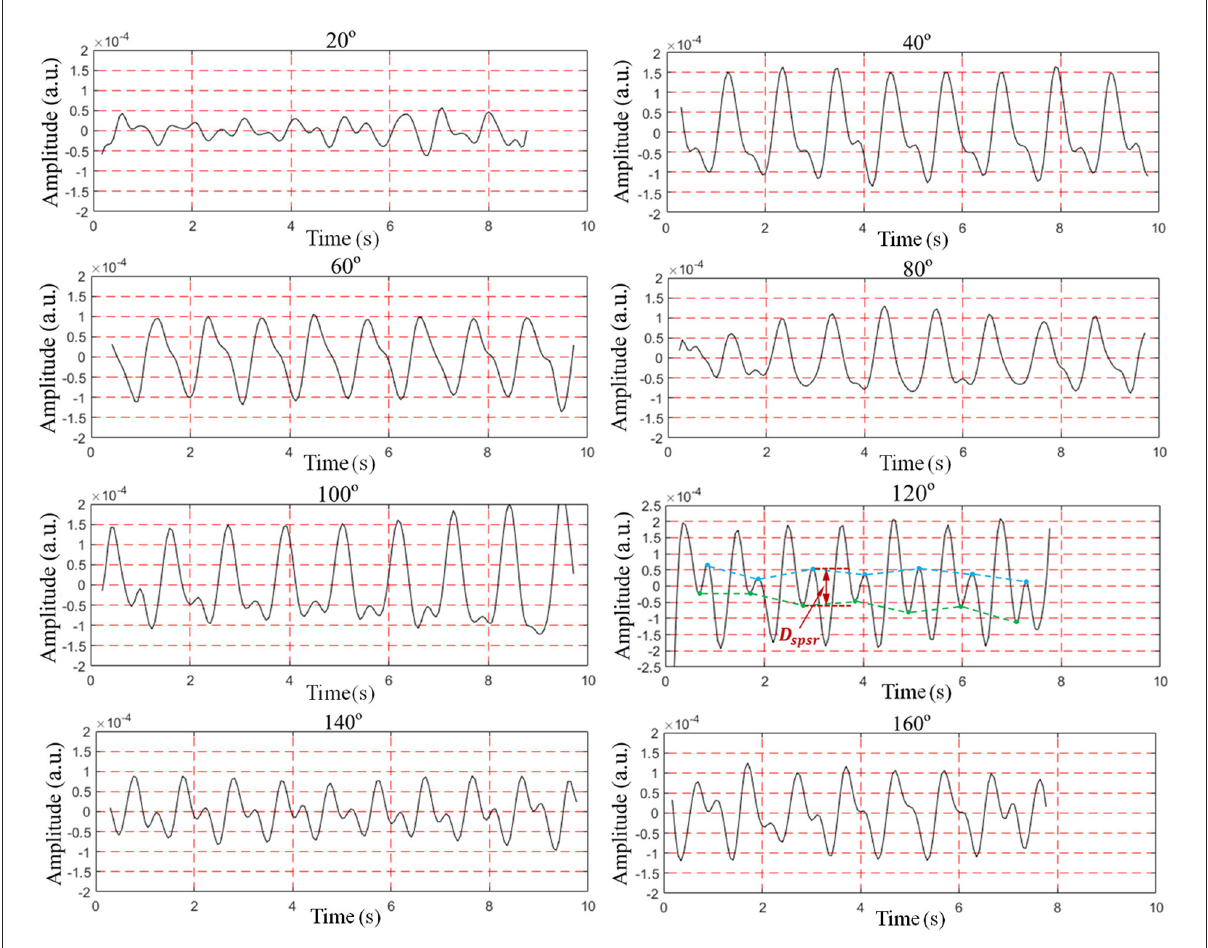
FIGURE12 RCG results at different